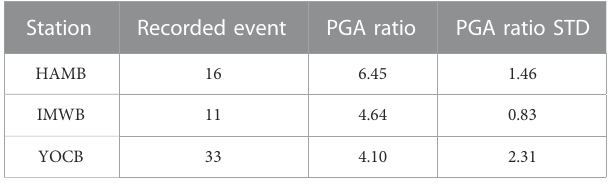
TABLE 2 PGA ratio of surface-to-within motion.